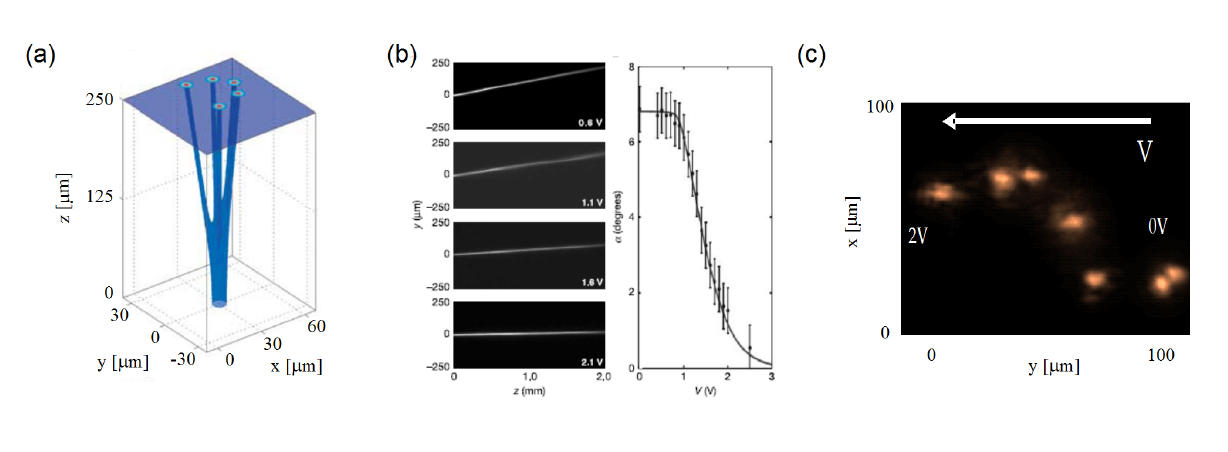
Figure 5. ( a ) Sketch of 3D beam steering via a uniform electric field applied across the NLC thickness ( i.e ., along x ); only walk-off changes are accounted for; ( b ) Photographs of nematicons propagating at different biases and a graph of corresponding apparent walk-off in the plane yz (dots with error bars are experimental data; the solid line is the theoretical prediction); ( c ) Superposition of the output beam profiles (after 1-mm propagation) for various applied voltages; these results also reveal the interaction of the nematicon with the cell boundaries ( h = 100 µm). The white arrow indicates an increasing bias. Here, the used wavelength was 1064 nm, and the input wavevector was parallel to ˆ z